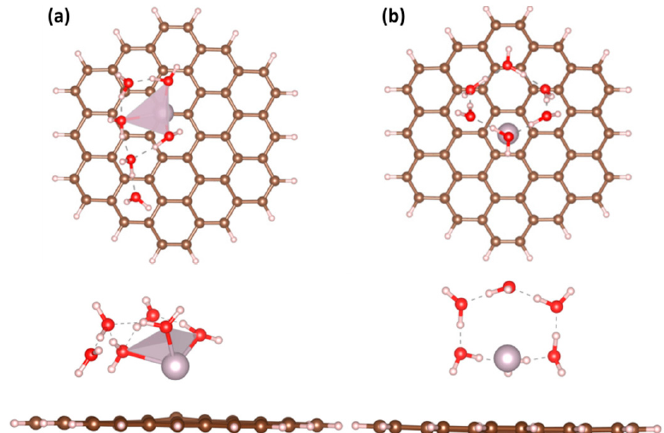
Figure 7. Side view and top view of the relaxed configurations of isolated ( a ) [Hg(H 2 O) 6 ] 2 + and ( b ) [Hg(H 2 O) 6 ] 0 complexes adsorbed on graphene. Brown, light pink, light magenta and red spheres represent C, H, Hg and O atoms, respectively. The polyhedra corresponding to bond generation are grey colored.